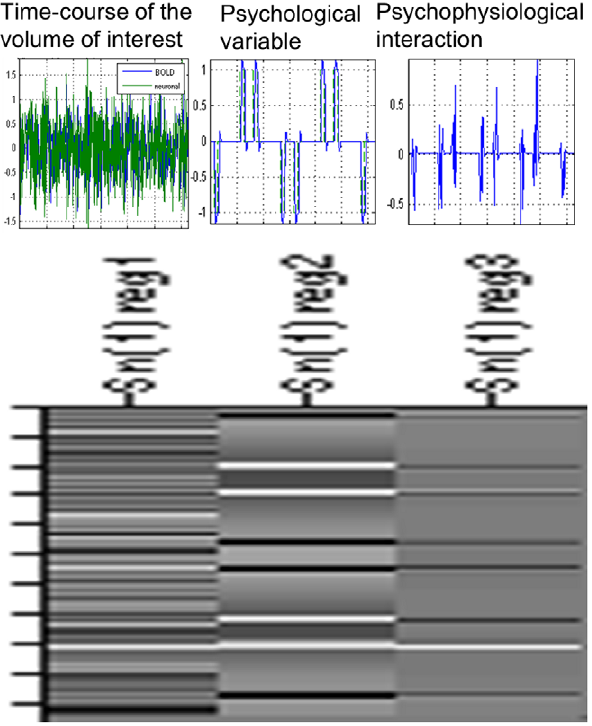
Figure 3. The schema of the design matrix used for PPI analysis of one session. The left column and left figure represent the time- course of the volume of interest (in case of analysis in this study, the right DLPFC). The middle column and middle figure represent the psychological variable (the effect of WM-specific speed; {(2-back Fast 2 2-back Slow) 2 (0-back Fast 2 0-back Slow)}. The right column and right figure represent PPI.